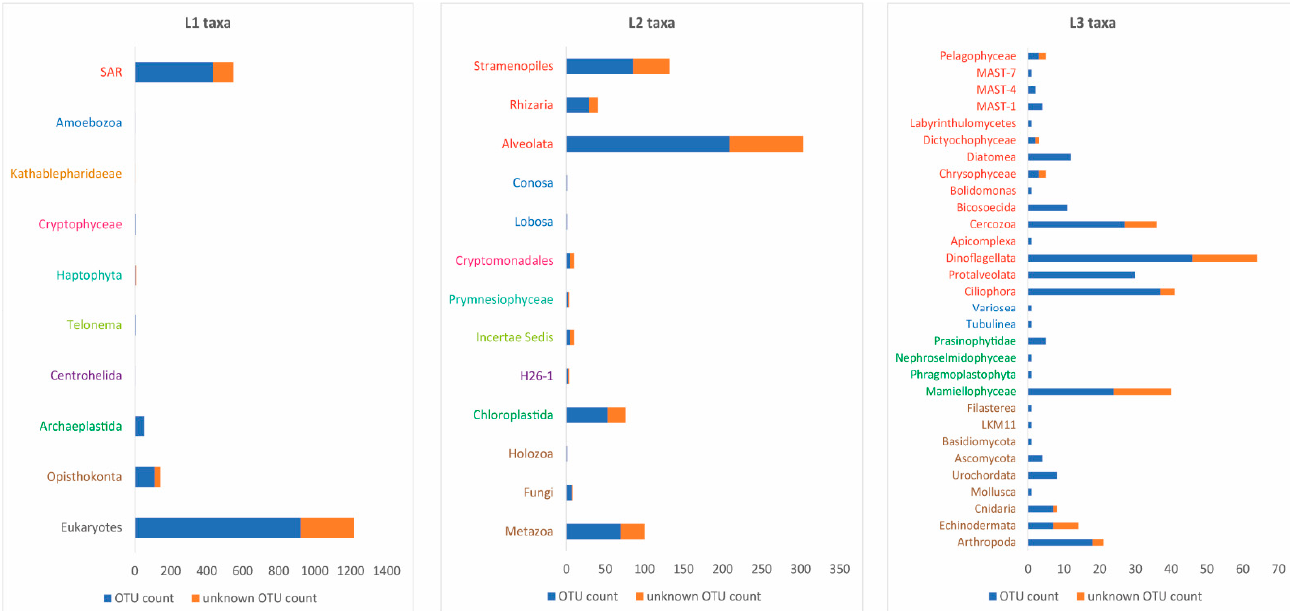
Figure 7. RDP classified OTU with an 80% or more confidence score at three levels L1 (Kingdom), L2 (Phyla) and L3 (Phyla to class level). Blue bars are the number of OTUs within taxa categories, and orange bars show OTUs that have not been further classified. The horizontal axis shows the number of OTUs. The colors of taxa names relate to members in a kingdom: red for taxa belonging to SAR, brown for Opisthokonta, green for Archaeplastida and blue for Amoebozoa. L2 Light Incertae Sedis belongs to Telonema and is coded in the same light green color.